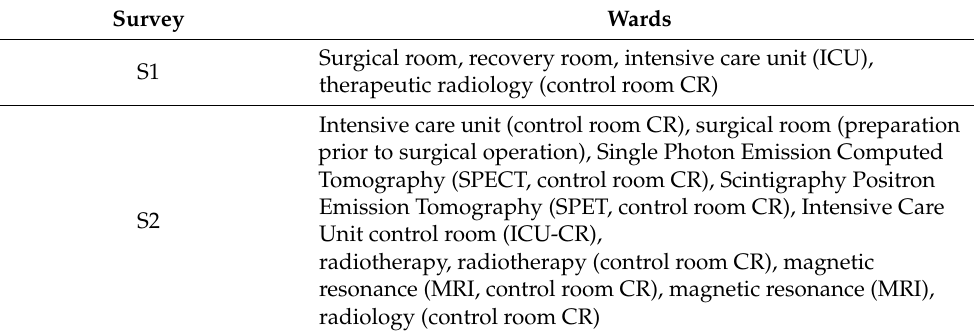
Table 1. Investigated wards in the two surveys.